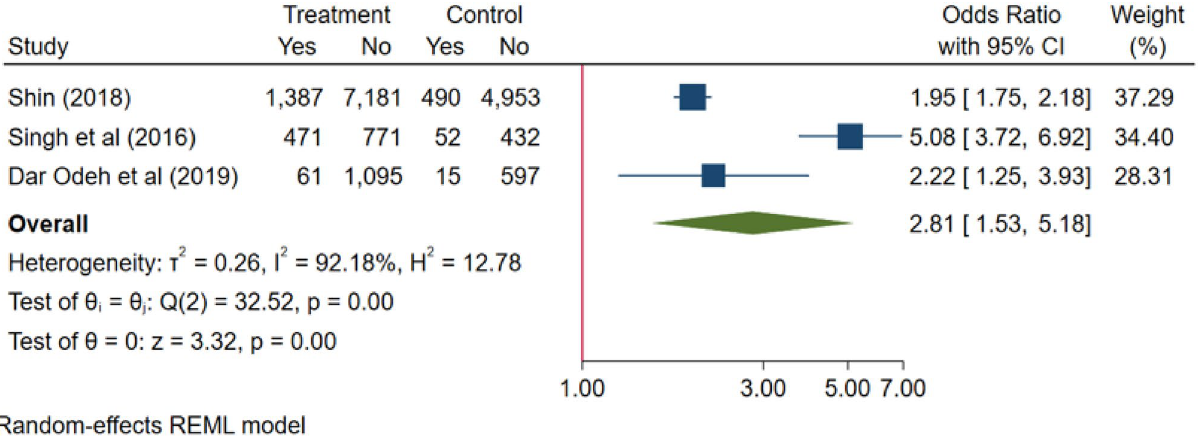
Figure 2. Forest plots of the Odds ratios with corresponding 95% Cis of studies on non-tooth loss/tooth loss and risk of